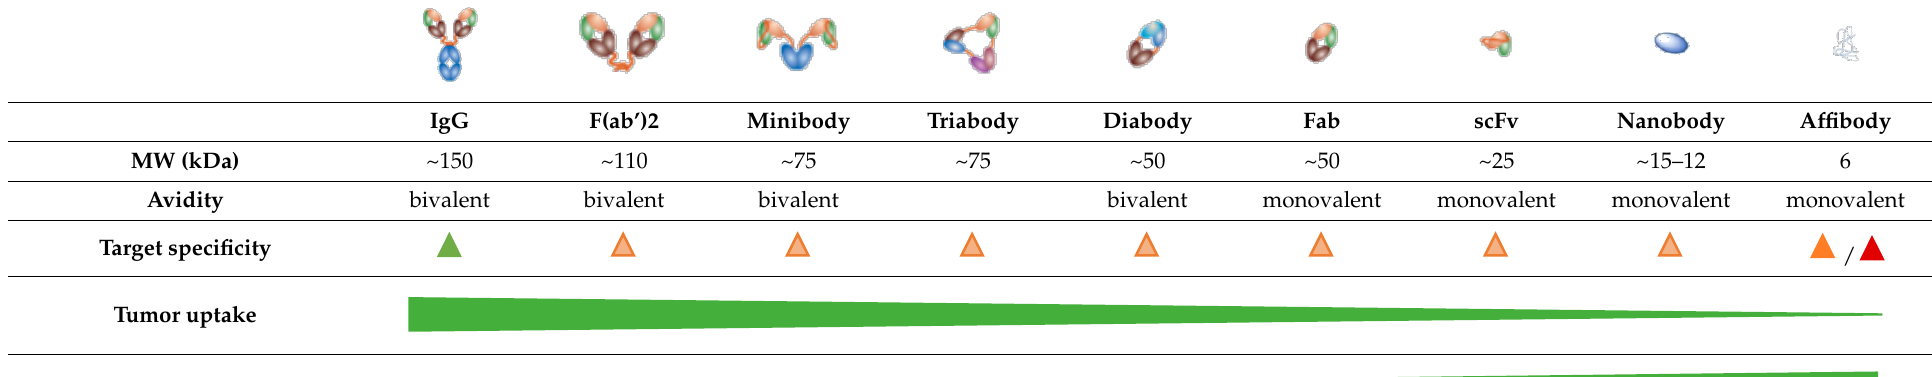
Table 3. Summary of the key properties of intact antibodies, antibody fragments, nanobodies, and affibodies [10,17].